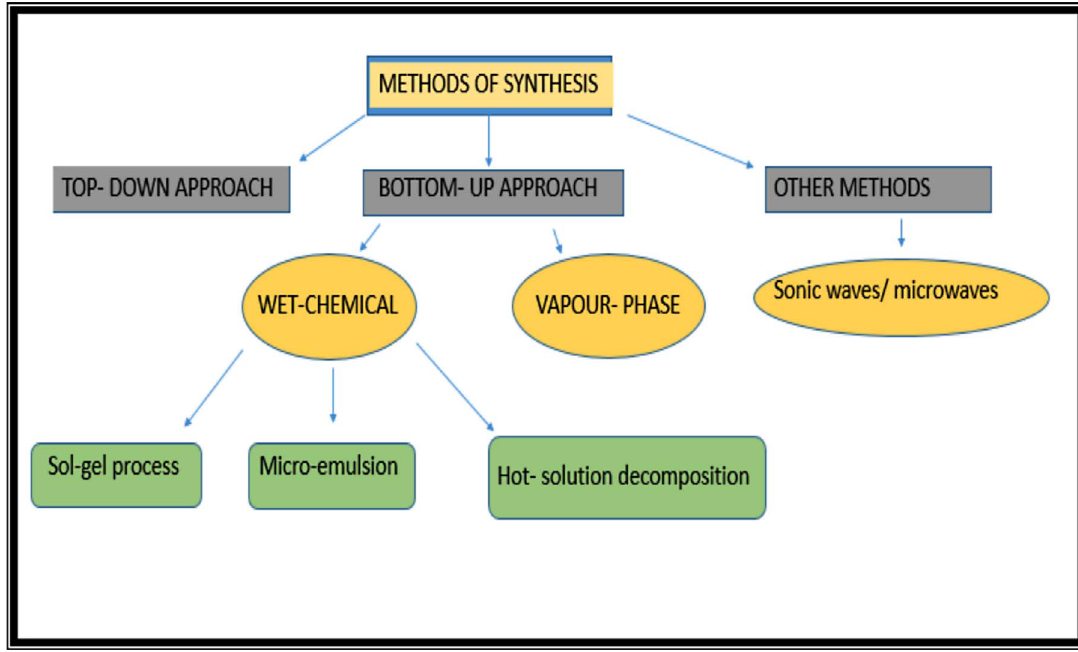
Figure 1. Various methods of synthesis of QDs (the synthesis method affects their sizes and various properties).